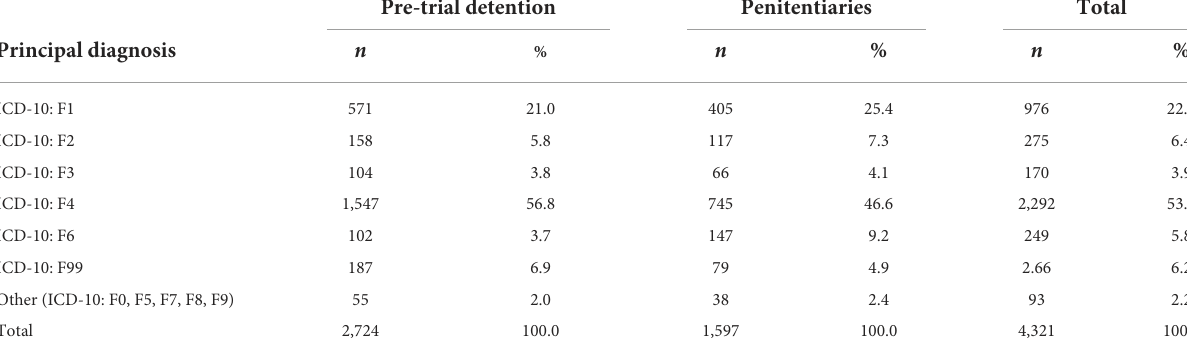
TABLE 3 Comparison of principal diagnoses in individuals receiving primary psychiatric care between 2014 and 2018 by type of correctional setting ( N =